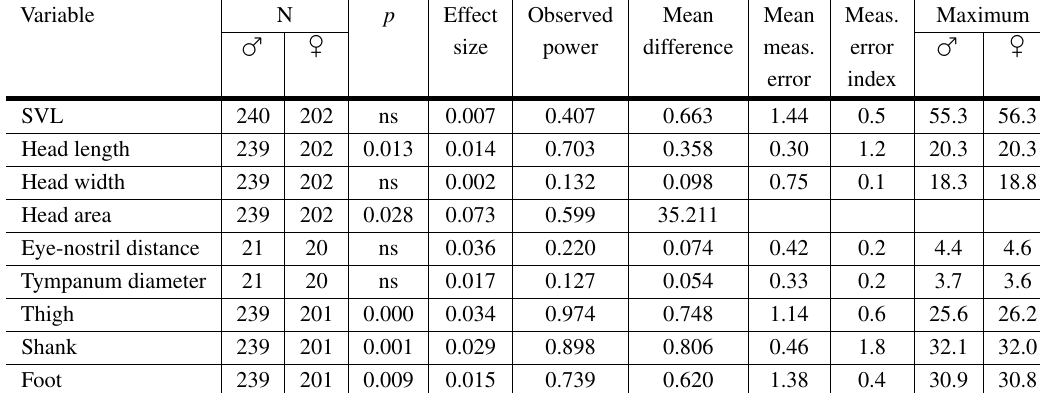
ANOVA and ANCOVA results for Leptodactylus fuscus and L. podicipinus measurement data. Meas. = measurement. All mean difference values are positive; female values are greater than male values. Leptodactylus fuscus – ANOVA for entire species